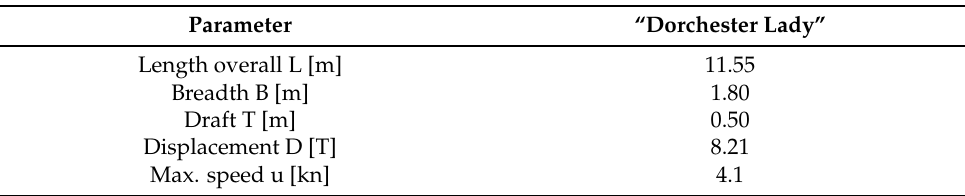
Table 1. Training ship